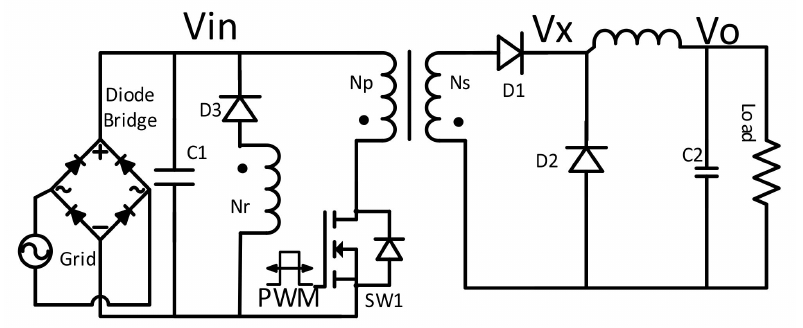
Figure 1. Conventional forward